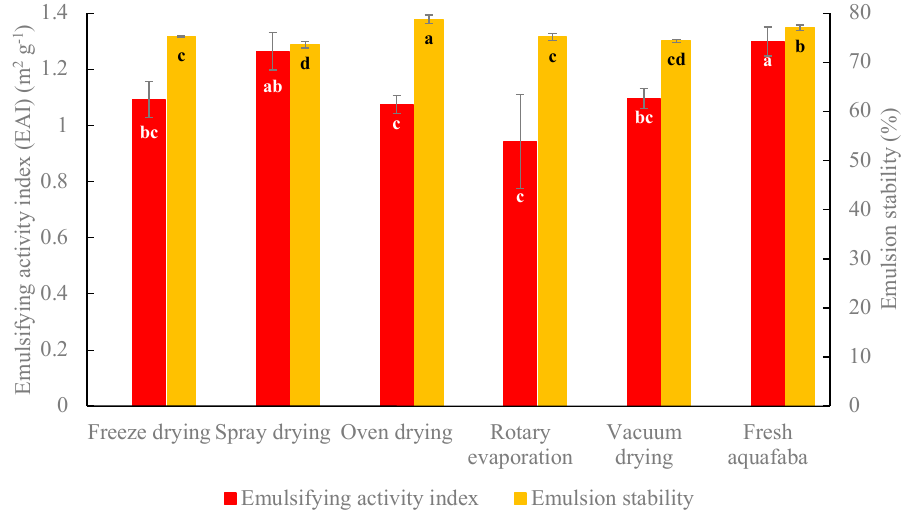
Figure 3. Emulsifying activity index and emulsion stability of rehydrated aquafaba dried by different drying methods. Different letters (a–d) refer to significant differences among different drying methods according to Tukey’s test ( p < 0.05).